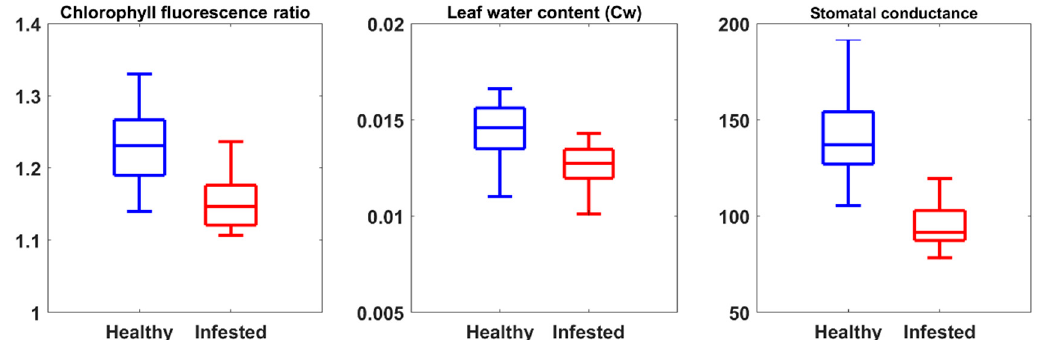
Figure 4. Distribution of measured leaf traits for healthy and infested needles, in the Bavarian Forest National Park, July 2016. There is a significant difference ( p < 0.05) in all measured leaf traits between healthy and infested samples.